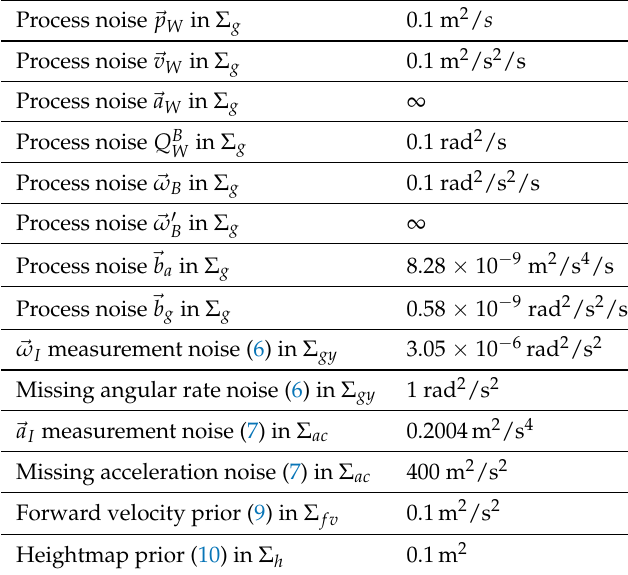
Table A2. Ref. [11] Covariances of the main